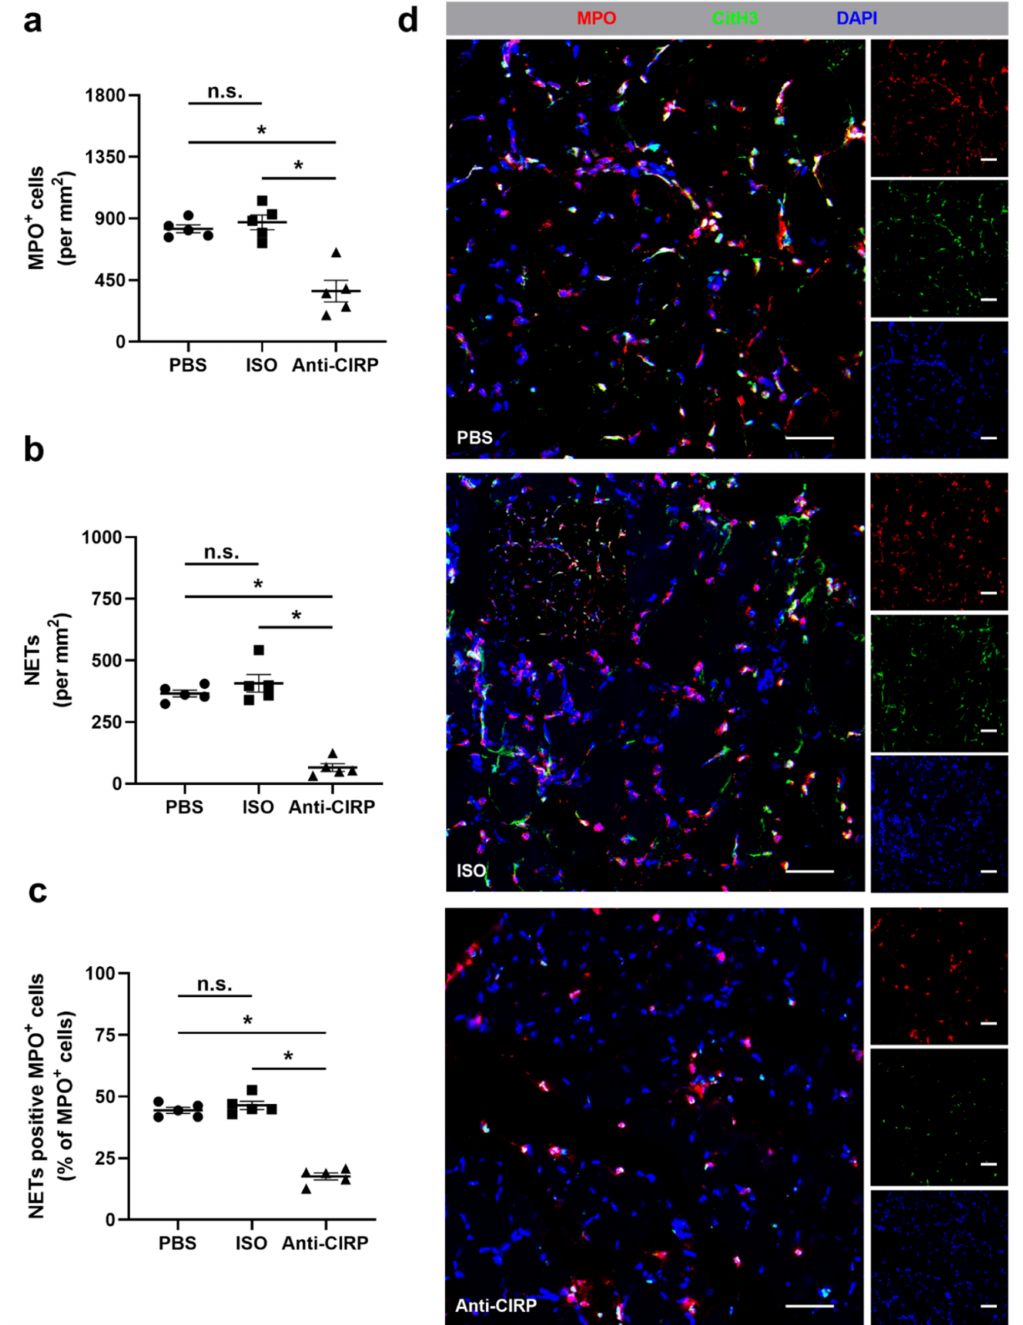
Figure 3. Depletion of extracellular “Cold-inducible RNA-binding protein” (eCIRP) interferes with neutrophil recruitment and neutrophil extracellular trap (NET) formation in ischemic muscle tissue. The scatter plots display the number of ( a ) MPO + (myeloperoxidase, marker for neutrophils) cells, ( b ) NETs (MPO + /CitH3 + (citrullinated histone 3)/DAPI + ) (both per mm 2 ), and ( c ) NET positive MPO + cells per total MPO + cells in ischemic gastrocnemius muscles isolated from phosphate-buffered saline- (PBS), isotype antibody- (ISO) (control groups) and anti-CIRP antibody- (Anti-CIRP) treated mice, isolated on day 1 after femoral artery ligation (FAL). Data are means ± S.E.M., n = 5 per group. n.s. p > 0.05, * p < 0.05 (PBS vs. ISO vs. Anti-CIRP) by one-way ANOVA with the Tukey’s multiple comparisons test, a defined ischemic area (1.5 mm 2 ) of muscle tissue was analyzed per mouse. ( d ) Representative immunofluorescence staining of ischemic gastrocne- mius muscle slices of PBS- (top), isotype antibody- (middle), and anti-CIRP antibody-treated mice (bottom) collected 1 day after FAL. Images display single and merged channels of neutrophils (MPO + /DAPI + ) and NETs (MPO + /CitH3 + /DAPI + ) labeled with anti-MPO (red), anti-CitH3 (green), and DAPI (nucleic acid, blue). Scale bars represent 50 µ